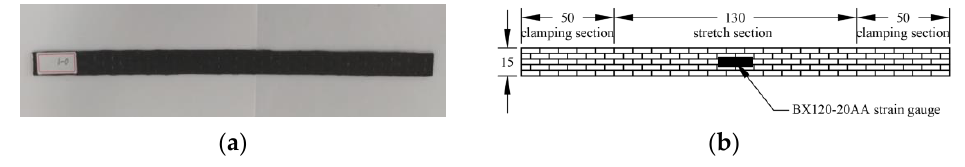
Figure 3. CFRP sheet: ( a ) sheet and ( b ) size and position of strain gauge.